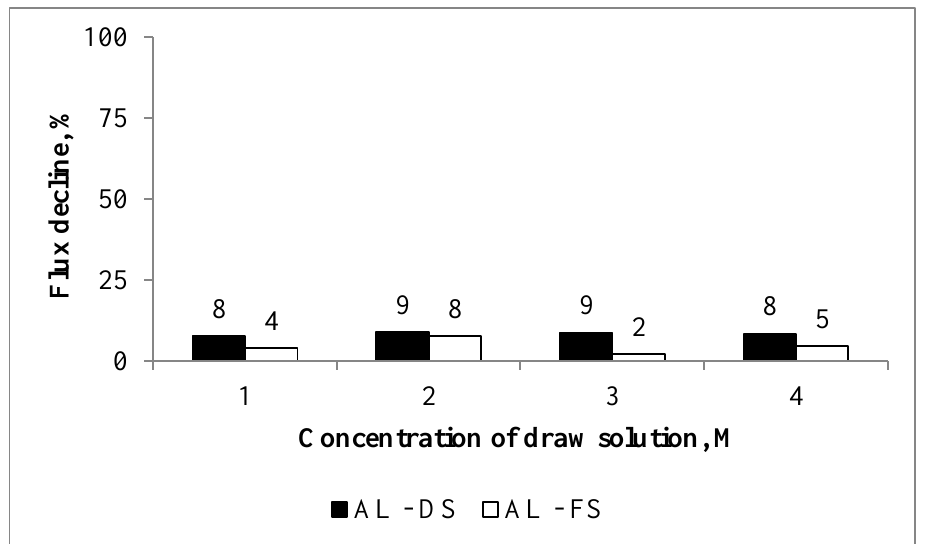
Figure 2. The decline in the flux observed for the baseline experiments. Experimental conditions: concentrations of NaCl, CaCl 2 , and Na 2 SO 4 in the feed are 10, 0, and 0 mM, respectively; 12.5 cm/s cross-flow velocity; and the feed and draw solutions were circulated counter-currently.